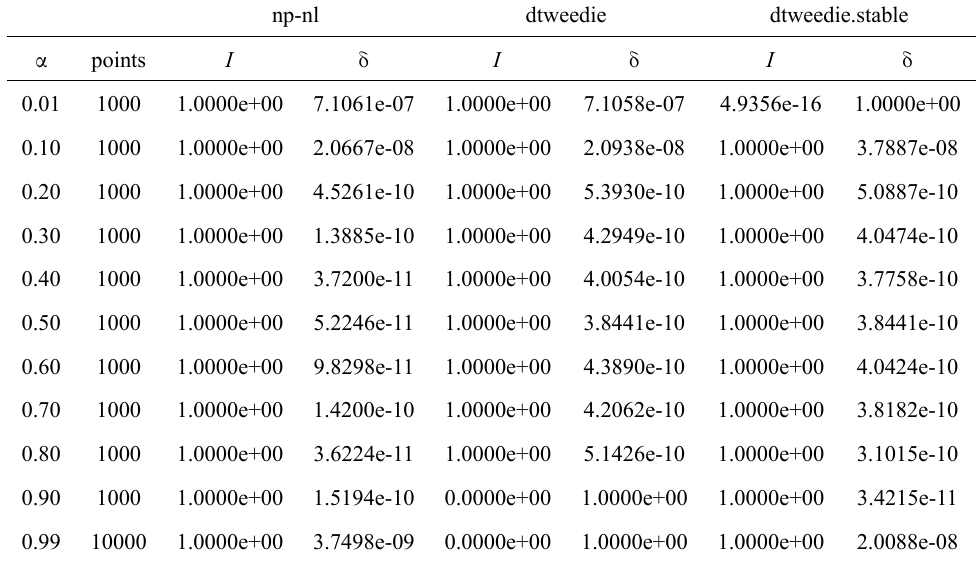
Numerical integration of Tweedie densities using Gaussian quadrature for np-nl (1000- bit precision), dtweedie and dtweedie.stable: I = (cid:82) f Z (z)dz the integral calculated with each version) and δ I = I – 1, with θ = – 1/2. np-nl dtweedie dtweedie.stable α points I δ I